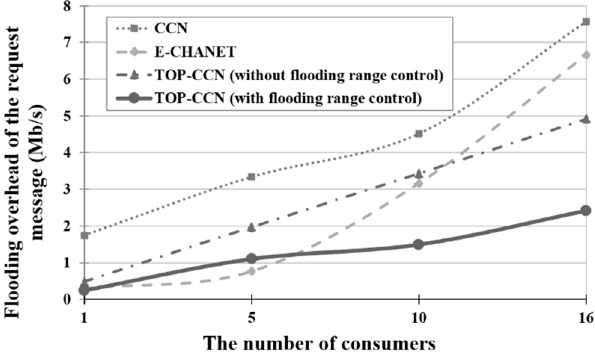
Figure 14. Flooding message overhead comparison depending on different number of firmware download users.